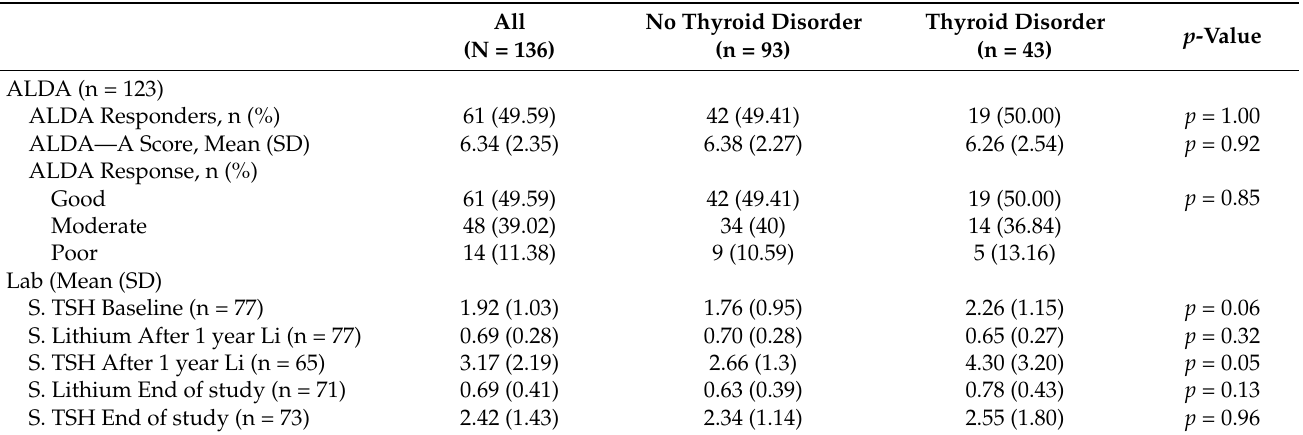
Table 3. ALDA Response and Laboratory